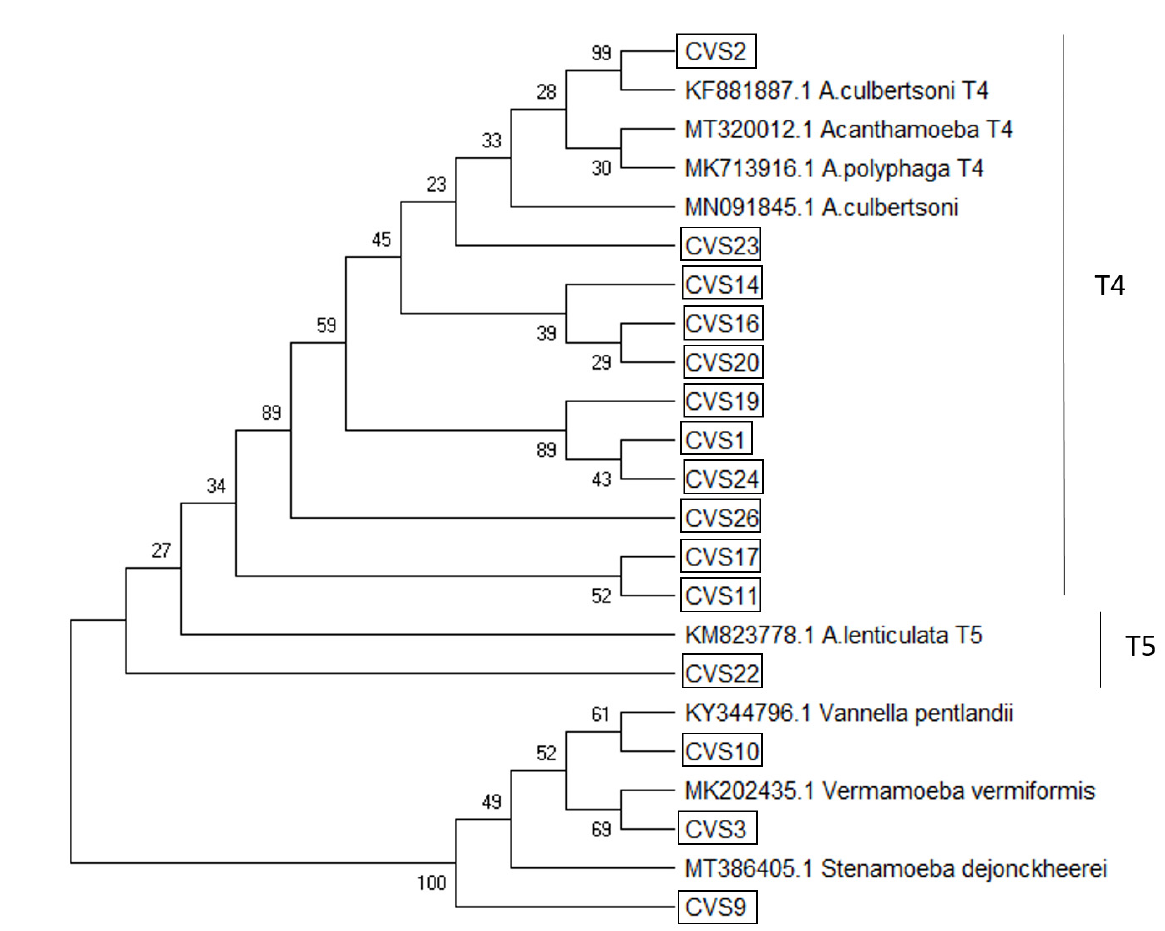
Figure 2. Original tree representing the evolutionary relationships of taxa carried out by the Neighbor-Joining method [22]. Phylogenetic relationship of the Amoebozoa strains isolated in the present study. The percentage of replicate trees, in which the associated taxa clustered together in the bootstrap test, are shown next to the branches [13]. The isolates obtained in the present study are identified in boxes.